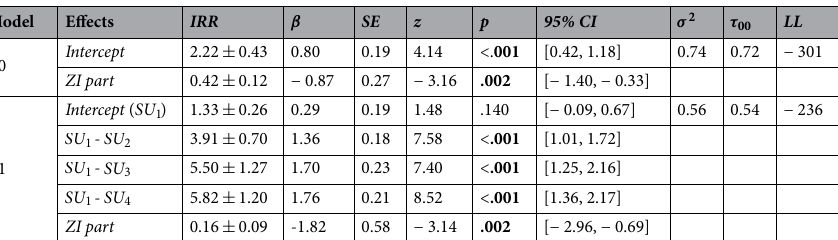
Table 2. GLMM analysis of the effect of expected surprise on the anticipatory saccade count during the foreperiod. IRR incidence rate ratio ± SE, β fixed effect coefficient, LL Log-likelihood, σ residual errors, τ 00 variance of level-2 residual errors. Significant values are in